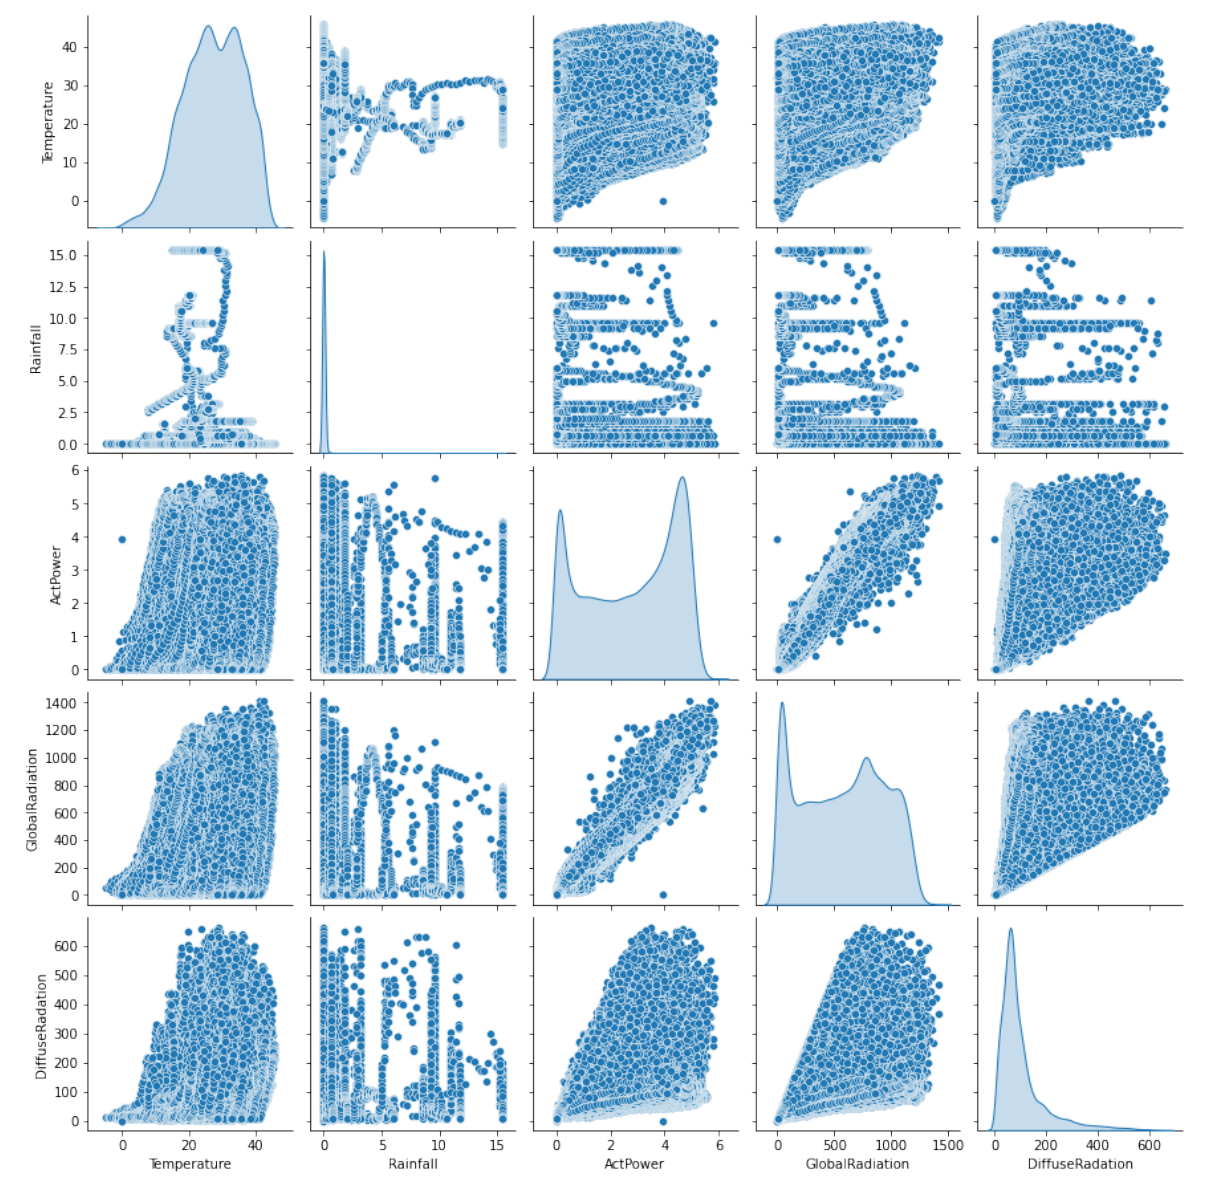
Figure 3. Feature selection: correlation of data set